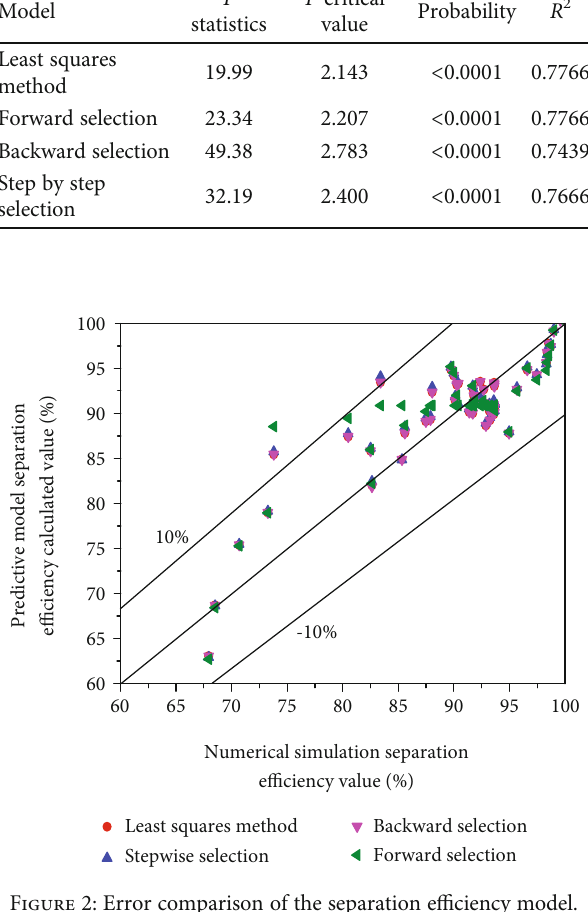
Figure 2: Error comparison of the separation e ffi ciency model.